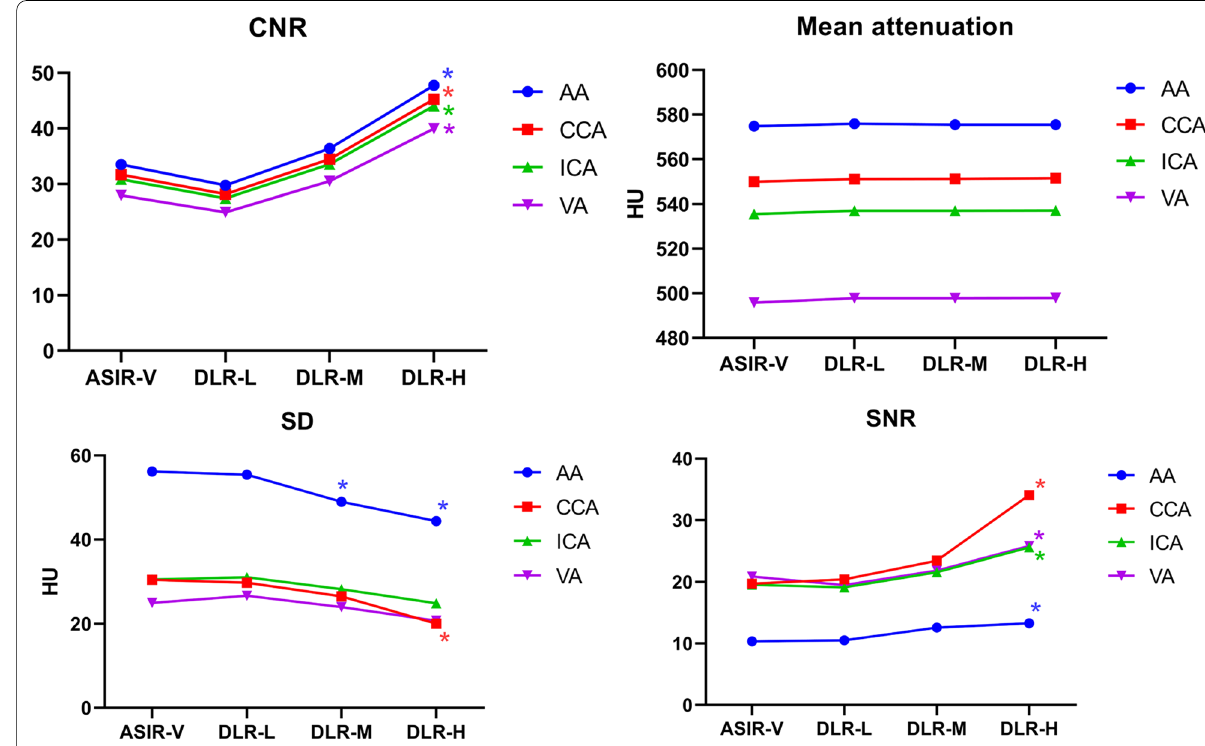
Fig. 1 Quantitative image analysis for arteries at all level between four reconstructed images. *Mean statistical higher than